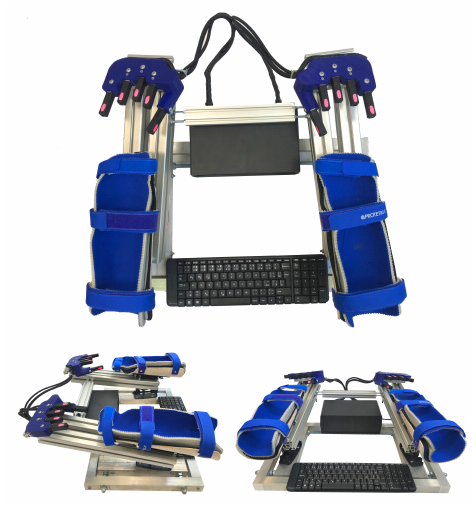
Figure 2. The Rehapiano